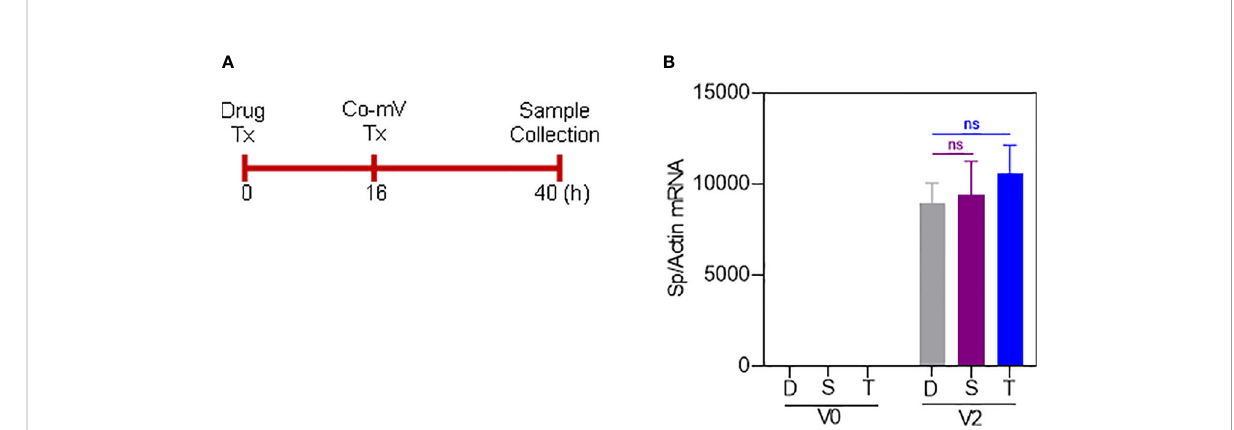
FIGURE 4 Sirolimus and Tacrolimus did not alter the uptake of P fi zer-BioNTech Co-mV in HEK293 cells. (A) Schematic of the drug and P fi zer BioNTech Co-mV treatment schedule in HEK293 cells. (B) HEK293 cells were transfected with 2 m g P fi zer Co-mV and without lipofectamine. RNA was puri fi ed and real-time qRT-PCR was performed using primer set 1 targeting a spike region in P fi zer-BioNTech Co-mV (as provided in materials and methods). RNA levels of spike were presented as 2 − DD CT values relative to house-keeping gene, actin. Results were expressed as the mean ± SD from four independent experiments (n = 4). Differences between the non-transfected and transfected groups and with DMSO and individual drug treatments were analyzed using a two-way ANOVA, Tukey post-hoc tests (multiple comparisons) (ns – not signi fi cant vs DMSO treated controls, as indicated). Tx, treatment; Co-mV, COVID-19 mRNA vaccine; V0, no CO-mV; V2, 2 m g Co-mV; D, dimethyl sulfoxide (DMSO); S, sirolimus; T, tacrolimus; Sp, spike; qRT-PCR, real-time quantitative reverse transcription-polymerase chain reaction; SD, standard deviation;